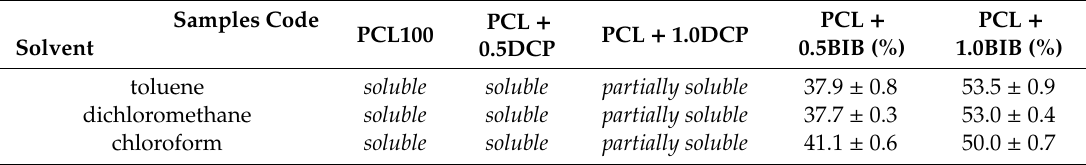
Table 6. Gel fraction content of modified PCL in the presence of the organic